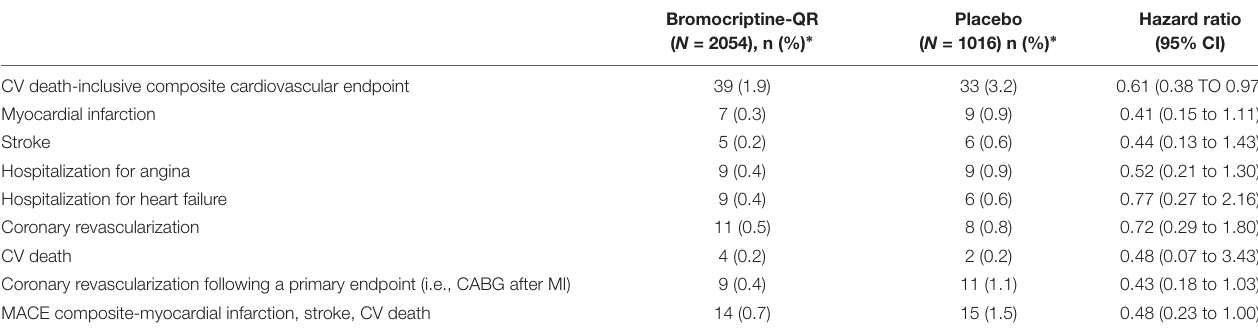
TABLE 2 | Impact of bromocriptine-QR on CV death-inclusive composite cardiovascular endpoint and individual components of the composite as well as the MACE